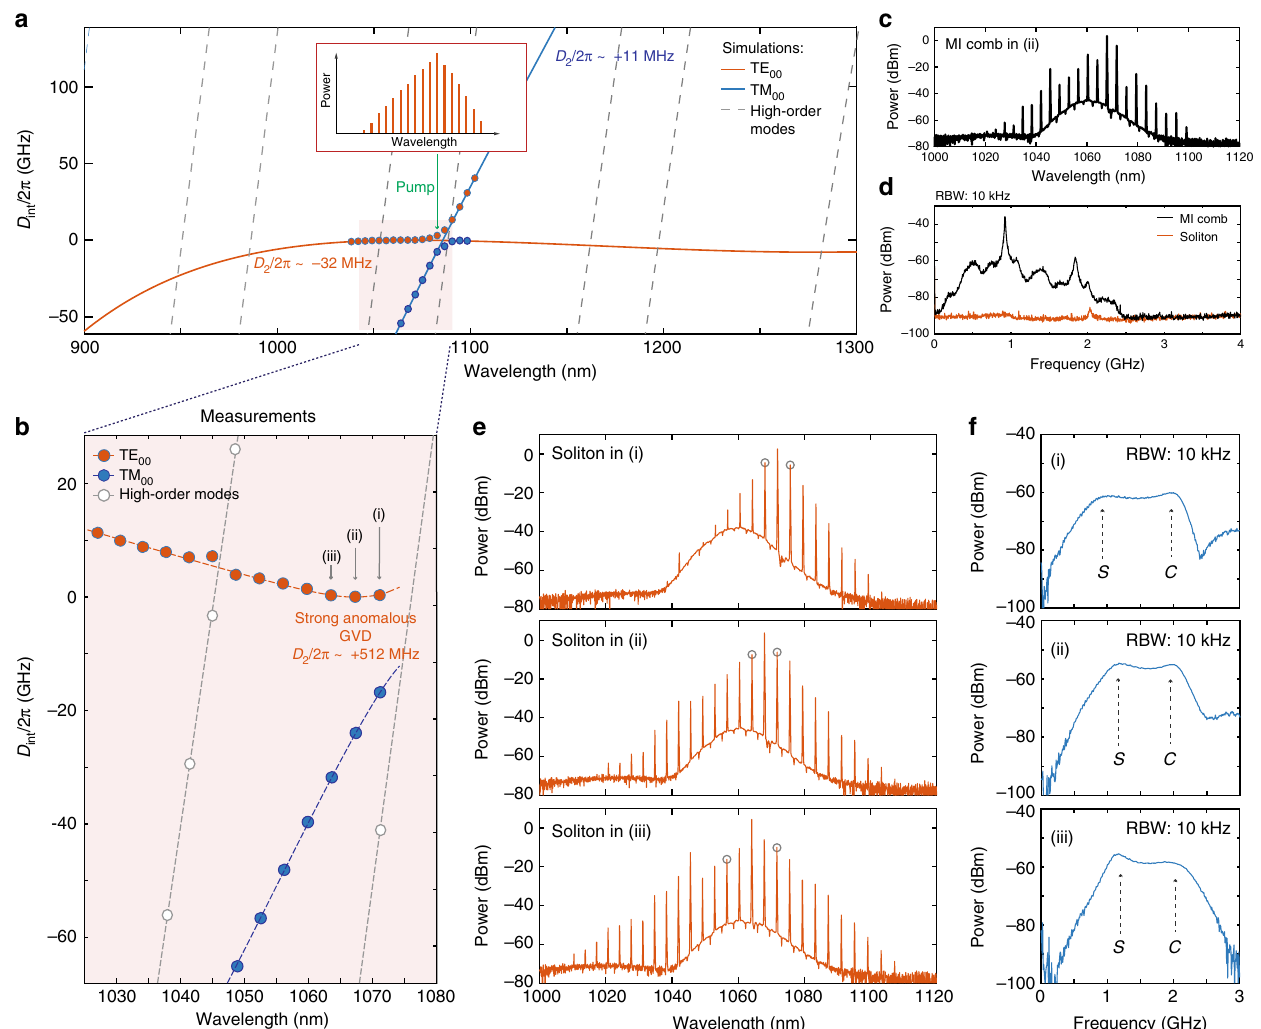
Fig. 4 Dissipative Kerr solitons in hybridised modes. a Scheme of the avoided mode crossing formation. Solid and dashed lines show the simulated integrated dispersion for the fundamental and high-order modes of 1-THz Si 3 N 4 microresonator with dimensions of 1.45 × 0.74 μ m. Red and blue circles schematically indicate the dispersion pro fi le of the hybridised modes forming AMX. b Measurements 54 of the mode structure of a 1-THz Si 3 N 4 microresonator with the dimensions of 1.45 × 0.74 μ m simulated in ( a ). Mode families are distinguished based on their FSRs. General dispersion trends cannot be faithfully identi fi ed due to the bandwidth limitations of our measurement setup, however a strong local anomalous group – velocity dispersion for three consecutive resonances (i), (ii), (iii) of the TE 00 mode family above 1064 nm can be observed. Dashed lines fi t the integrated dispersion of different modes within the measurements range. c Optical spectrum of a noisy comb state, obtained in resonance (ii) from ( b ). d Intensity noise measurements of the noisy modulation-instability comb (MI comb, black) and the dissipative Kerr soliton (soliton, red) states, obtained by pumping the resonance (i) from ( b ). e Optical spectra of the DKS states obtained by pumping resonances (i), (ii), (iii) from b . Grey circles indicate the positions of primary comb lines. f Response measurements of DKS states represented in ( e ). The positions of characteristic C -resonance and S -resonance are indicated with C and S letters,